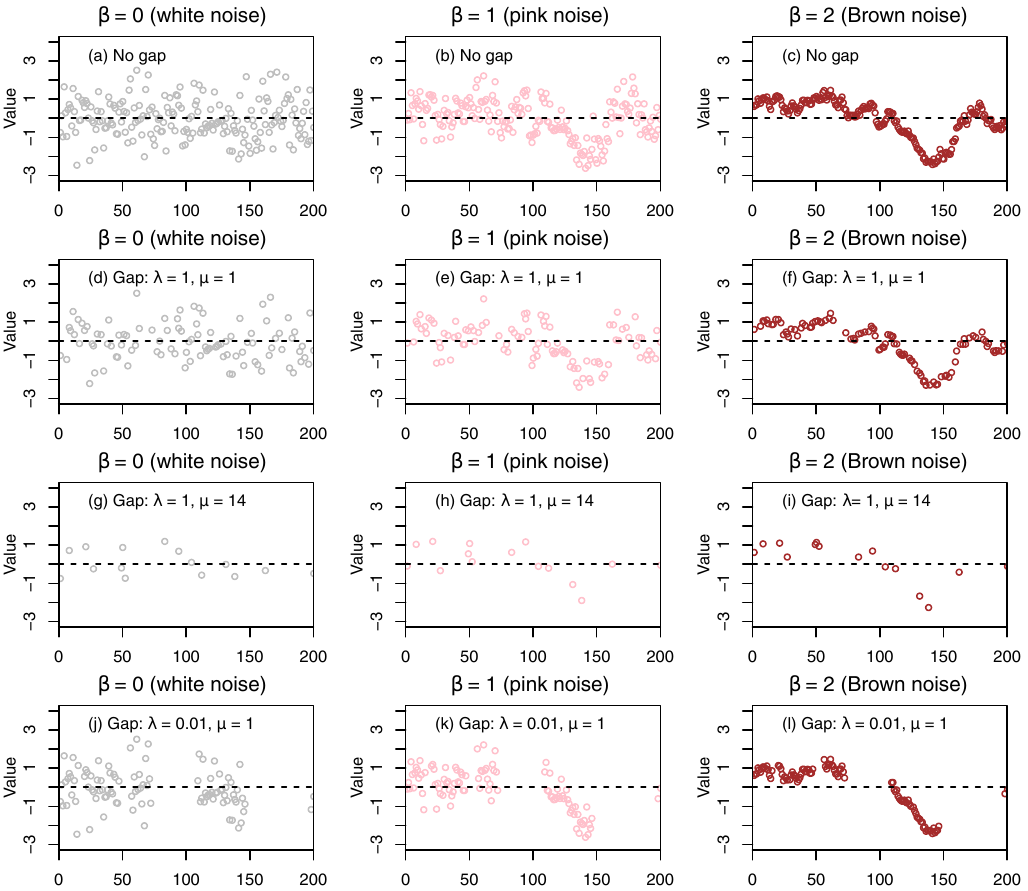
Figure 1. Synthetic time series with 200 time steps for three representative fractal scaling processes that correspond to white noise ( β = 0), pink noise ( β = 1), and Brown noise ( β = 2). (a–c) show the simulated time series without any gap. (d–l) show the same time series as in (a–c) but with data gaps that were simulated using three different negative binomial (NB) distributions – that is, (d–f) : NB( λ = 1, µ =